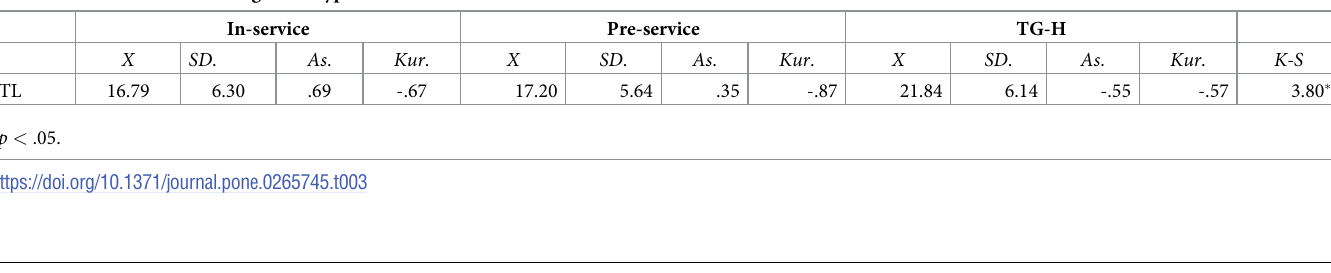
Table 3. eTL variables according to the type of